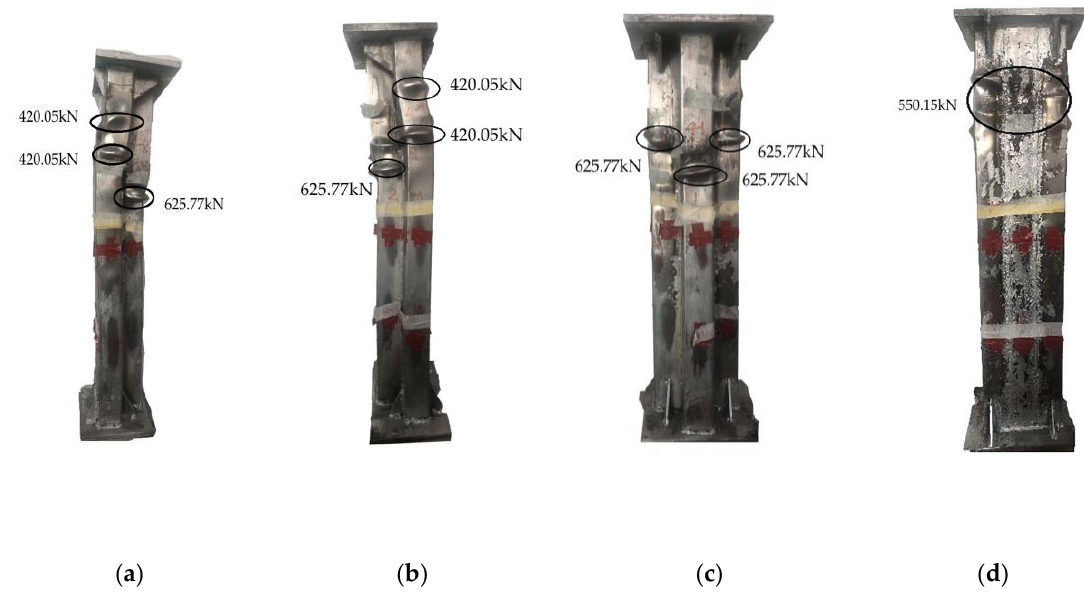
Figure 3. Deformation pattern of ( a ) the second surface; ( b ) the fourth surface; ( c ) the first surface; ( d ) Table 4 test